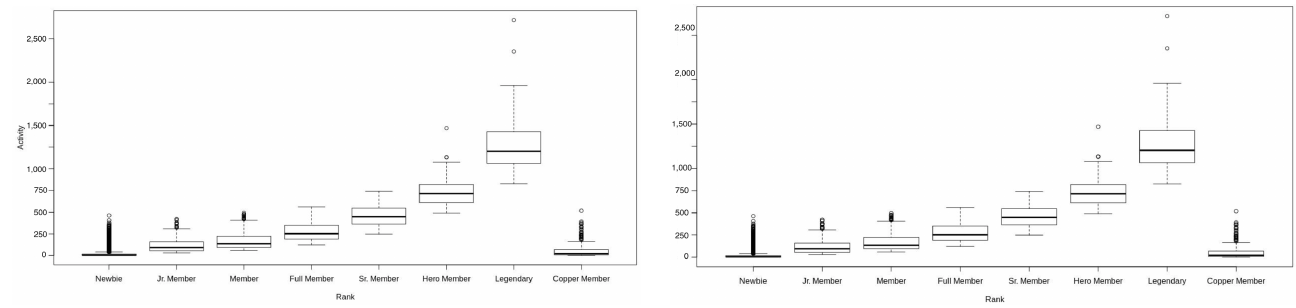
Figure 3. Distribution of activity and merit per rank (box-plots).